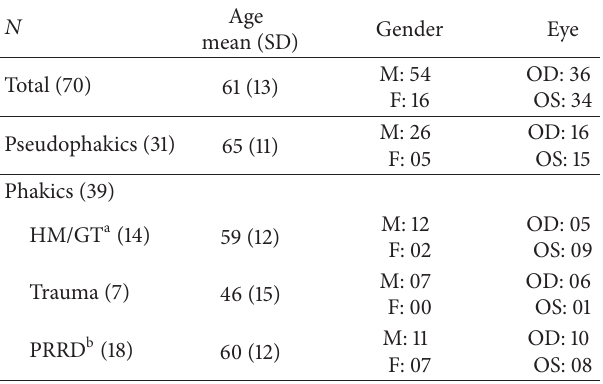
Table 1: Demographics of the study